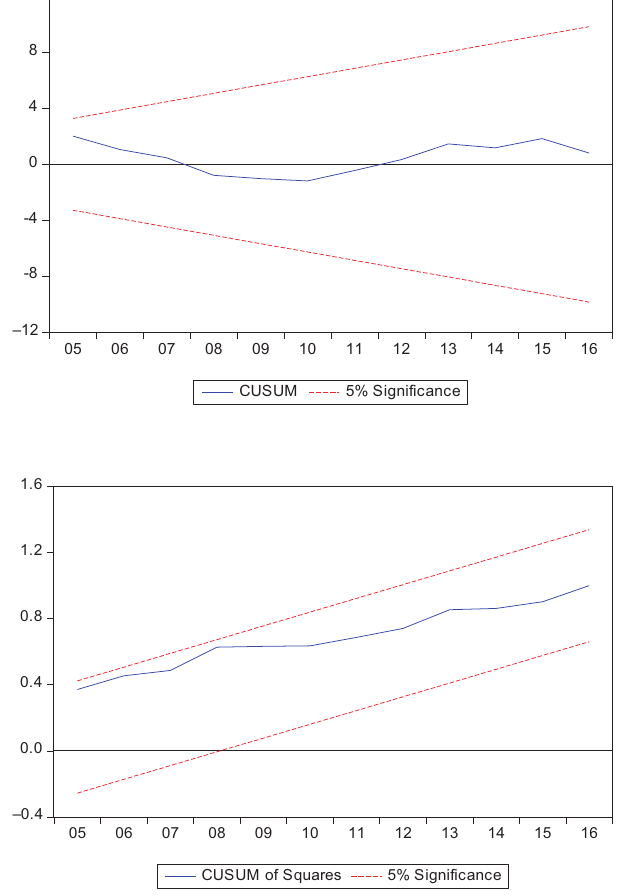
Figure 3. CUSUM square Model